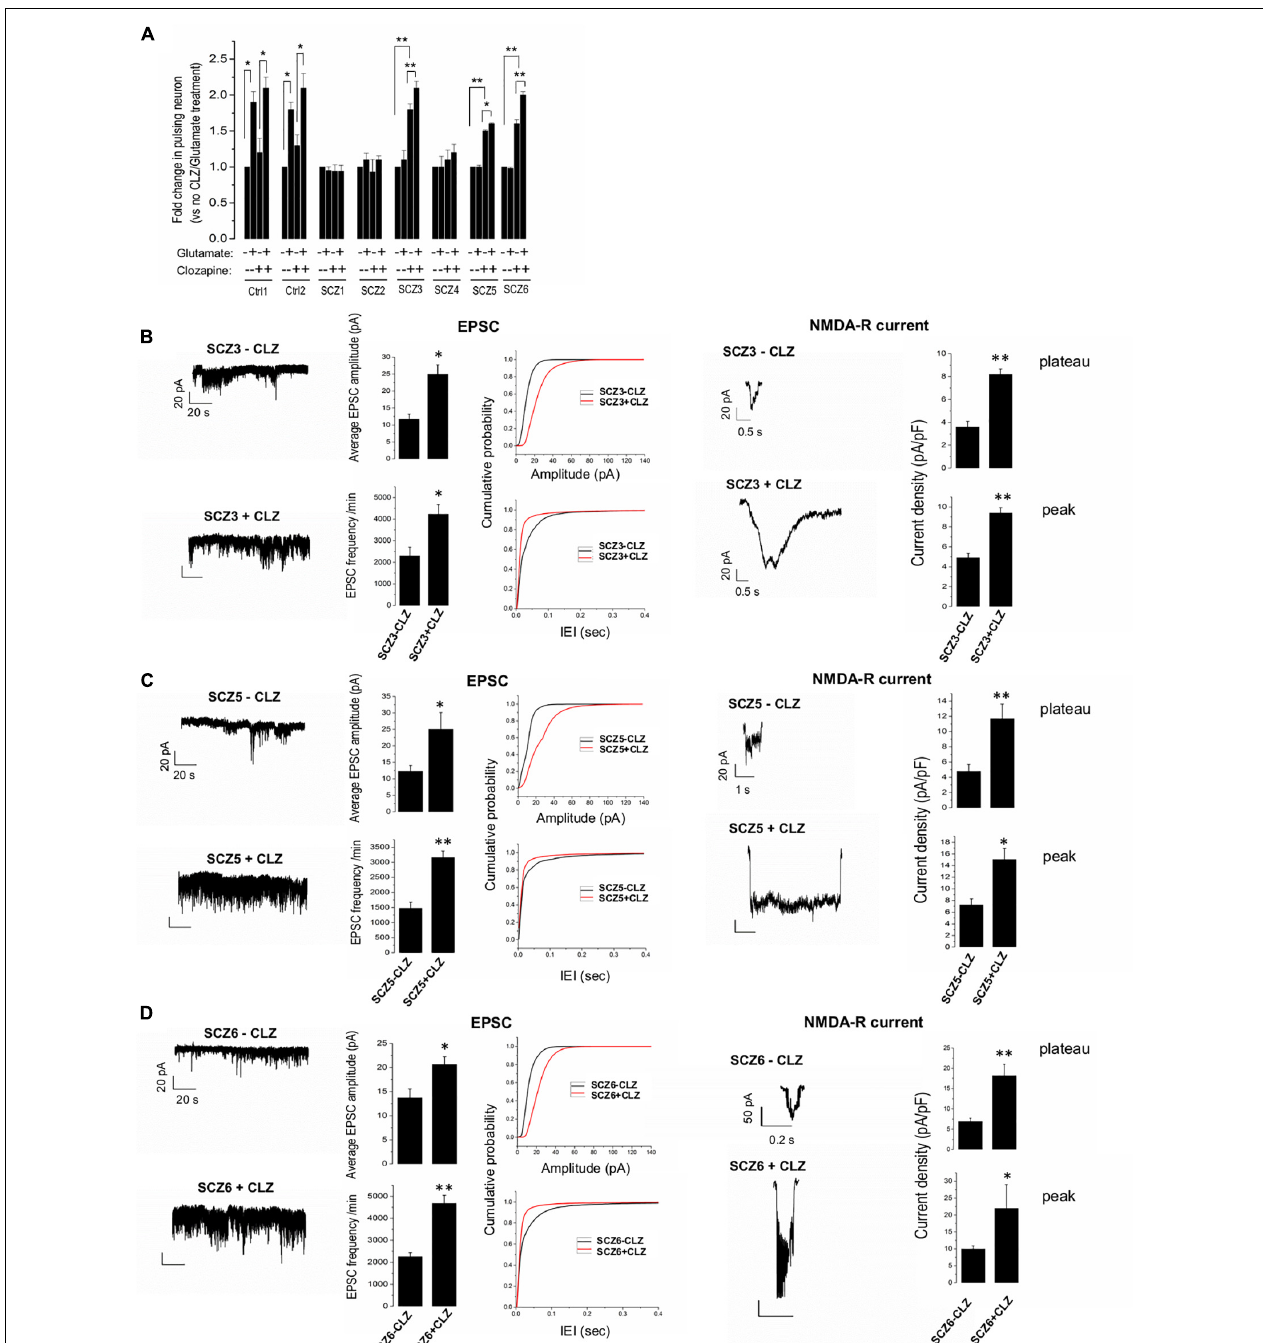
FIGURE 4 | EPSPs, NMDA currents, and the effect of clozapine. (A) Ca imaging with and without glutamate and clozapine exposure. (B–D) EPSC and NMDA currents with and without clozapine pretreatment in neuronal lines from clozapine responsive patients. The symbols represent significance levels: * p < 0.05; ** p <